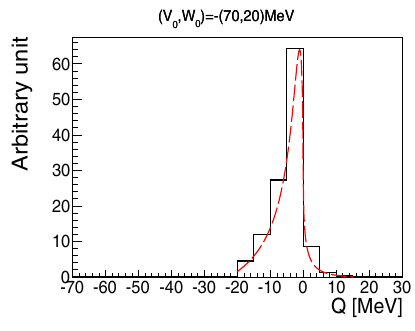
Figure 2. Cross section of the dd → ( 4 He- η ) bound → 3 He N π reaction for the formation of the 4 He- η bound system calculated for η - 4 He optical potential parameters ( V 0 , W 0 ) = − (70,20) MeV, plotted as a function of the excess energy Q. The red dashed line shows the theoretical spectrum while the black solid line shows the convoluted spectrum. Figure is adopted from Ref. [2].